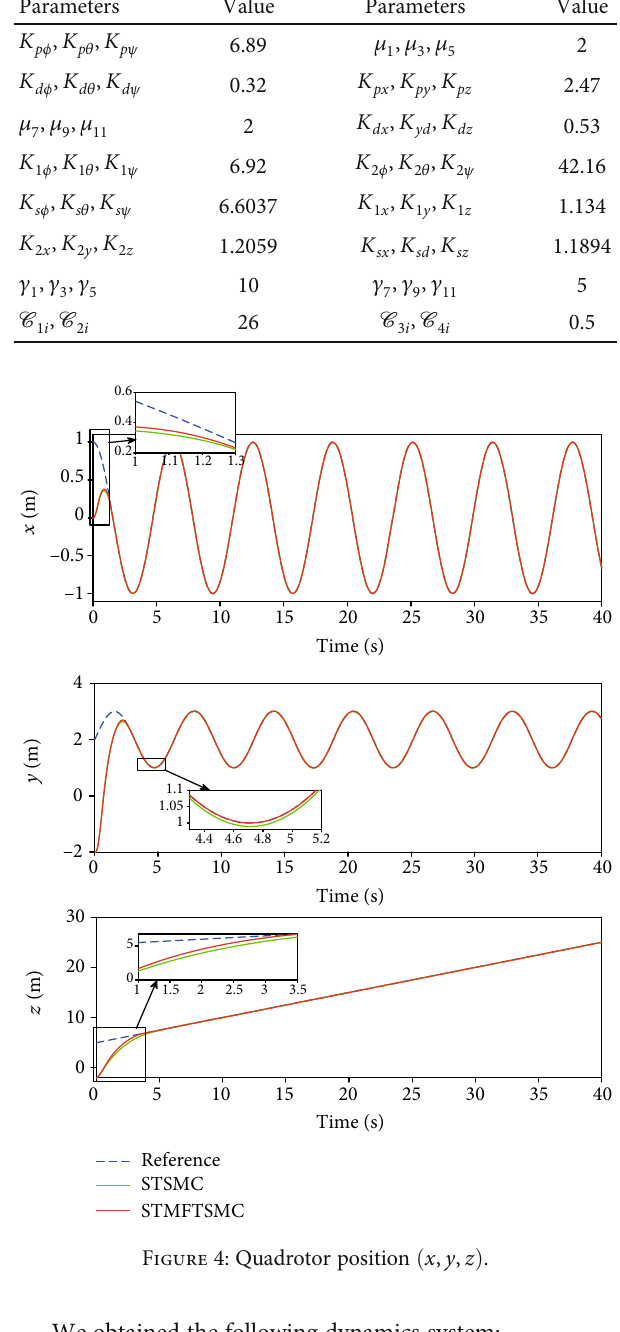
Figure 4: Quadrotor position ð x , y , z Þ .